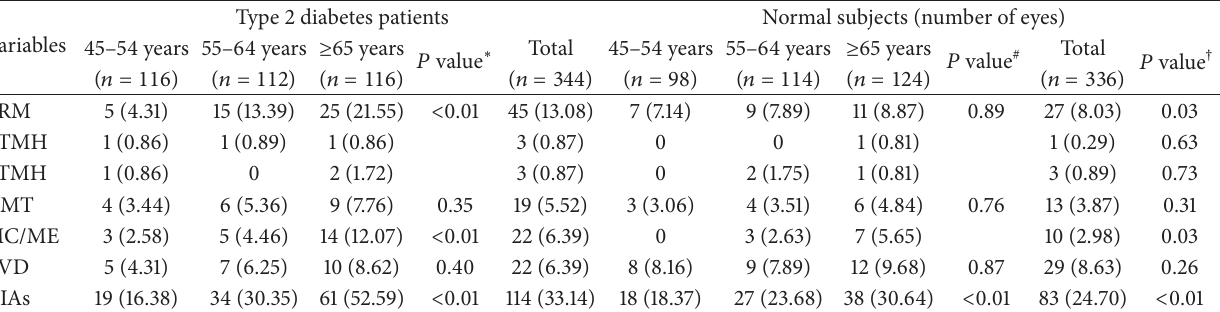
Table 4: The prevalence of VIAs within females in this study (number of eyes or %).